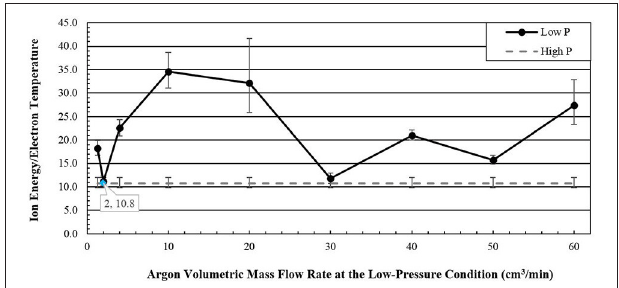
FIGURE 9 | Ion energy ratios for the “Low-Pressure” (Low P) and 2 cm 3 /min flow rate “High-Pressure” (High P)